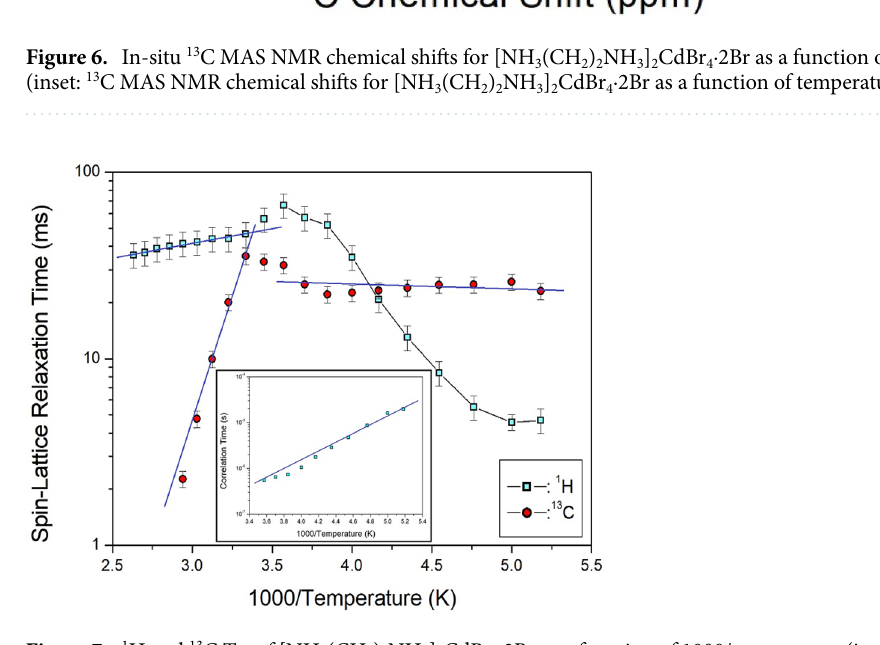
Figure 7. 1 H and 13 C T 1ρ of [NH 3 (CH 2 ) 2 NH 3 ] 2 CdBr 4 ·2Br as a function of 1000/temperature (inset: Correlation times for inverse temperature for 1 H at low temperature; the lines represent activation